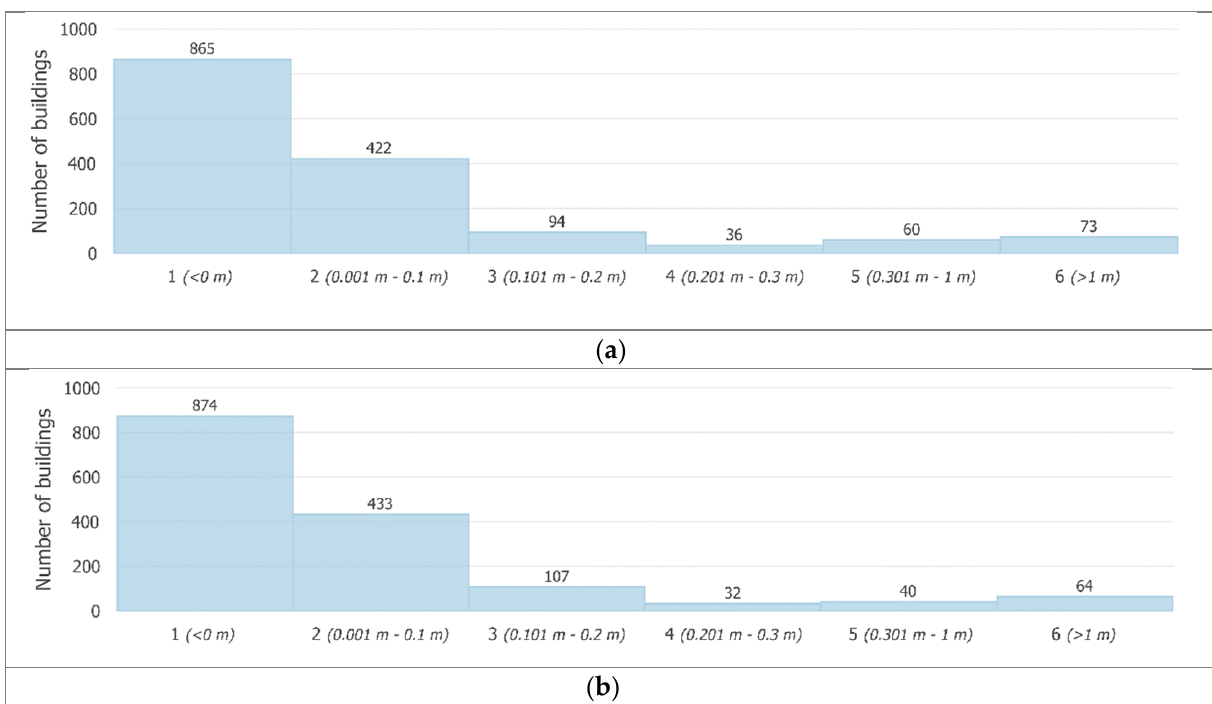
Figure 23. The histogram of absolute differences between ( a ) mean height and ( b ) median height residuals for two analyzed scenarios: corrected and not corrected.